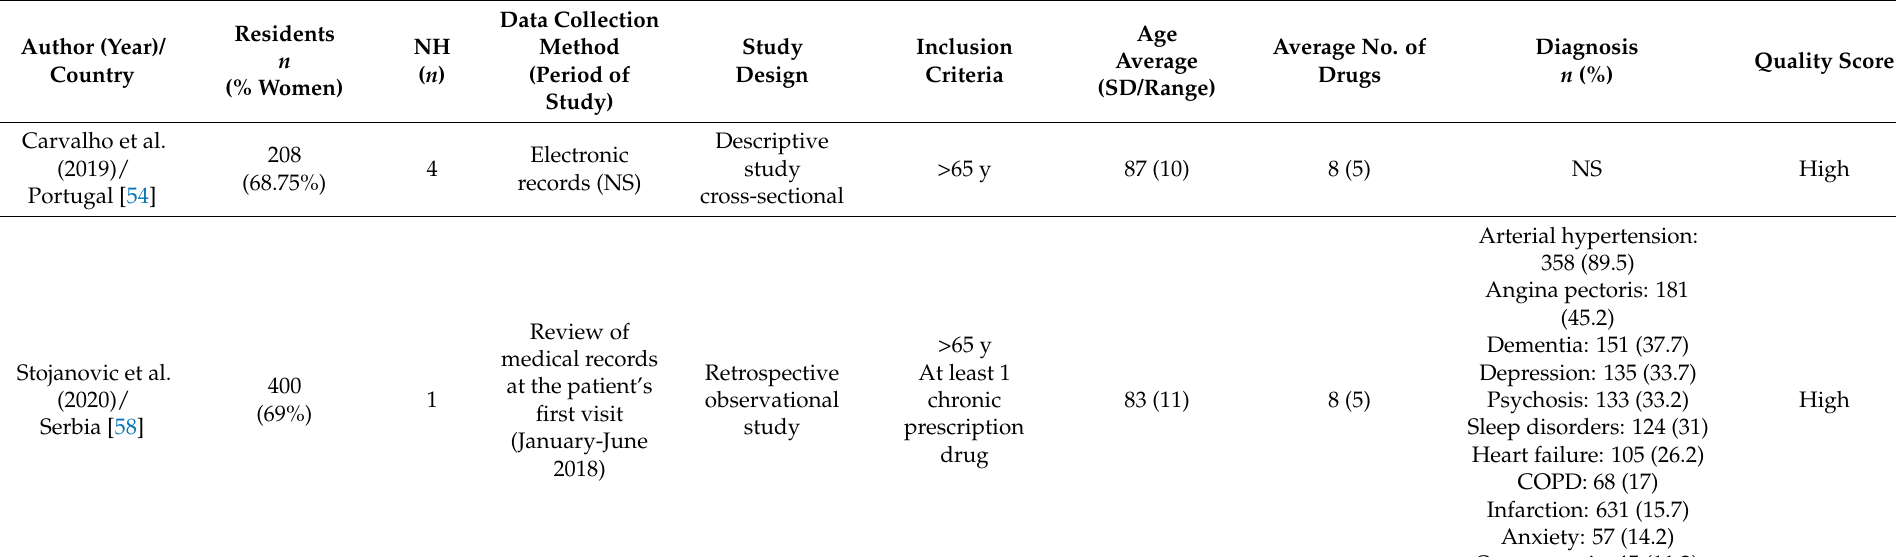
Table 2. Summary of the main characteristics of the studies and nursing home residents included in this